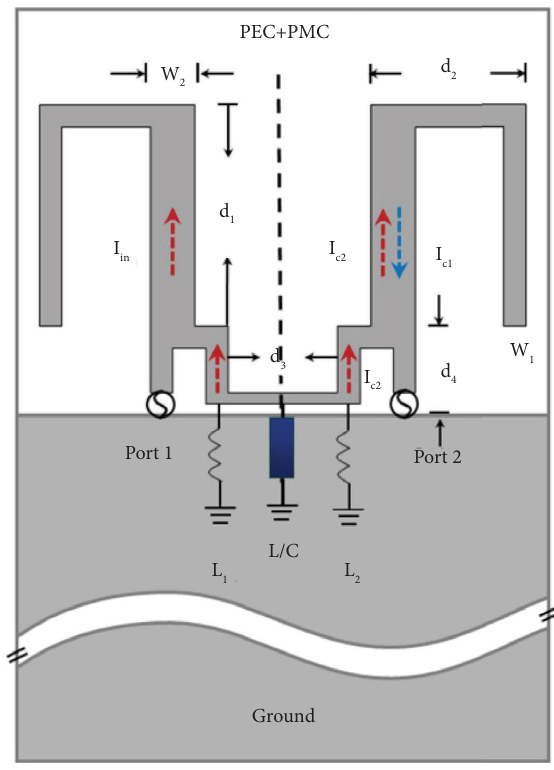
Figure 3: Geometry of a coupling reduction antenna system with the proposed PMC